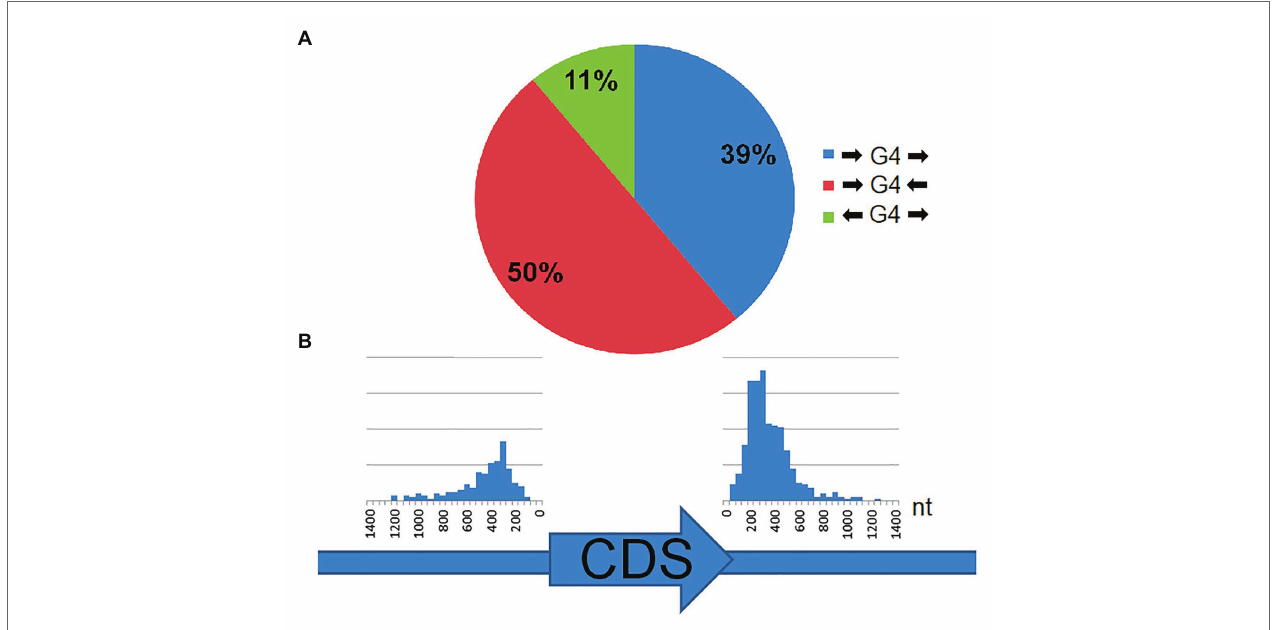
FIGURE 3 | Location of rPQSs in 12 genomes of Methanomicrobiaceae family with respect to the two nearest genes. (A) Circular diagram of the rPQS distribution between the pairs of genes with head-to-head, tail-to-tail, and head-to-tail orientation. (B) The distance (in nucleotides) distribution between rPQS and the start of a CDS (left) or the end of a CDS